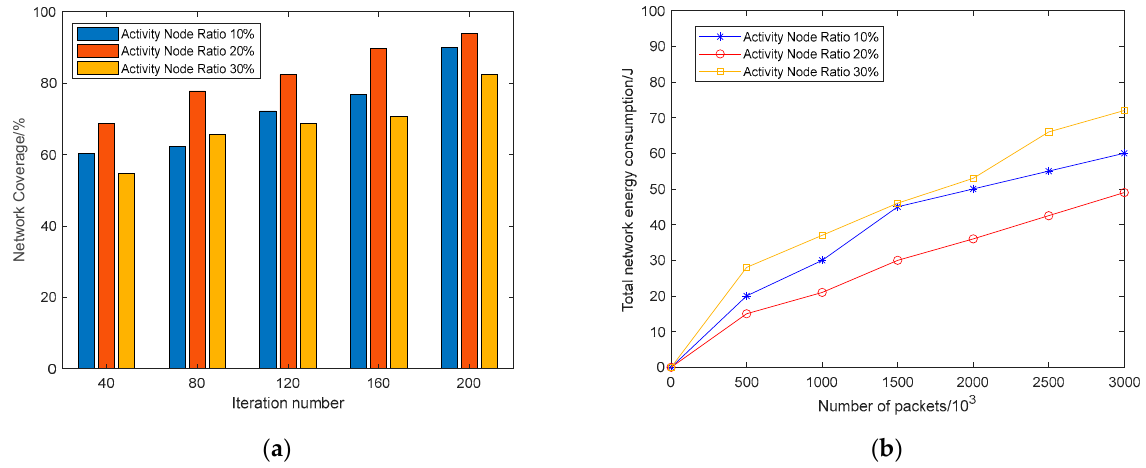
Figure 16. Determining the optimal ratio of activity nodes: ( a ) Coverage of different activity node ratios; ( b ) Total network energy consumption of different activity node ratios.